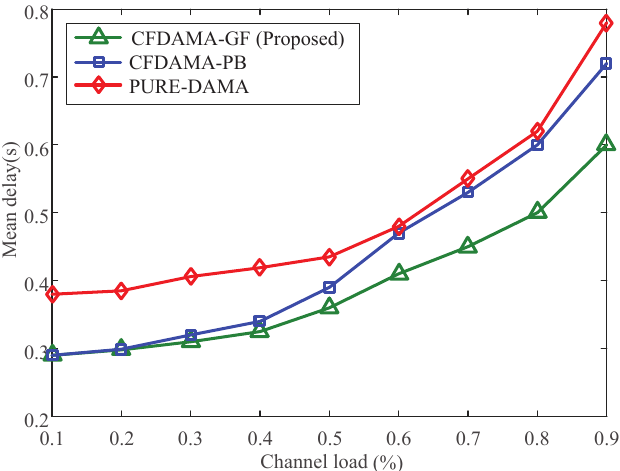
Figure 4. Comparison of the number of queued packets and channel load.